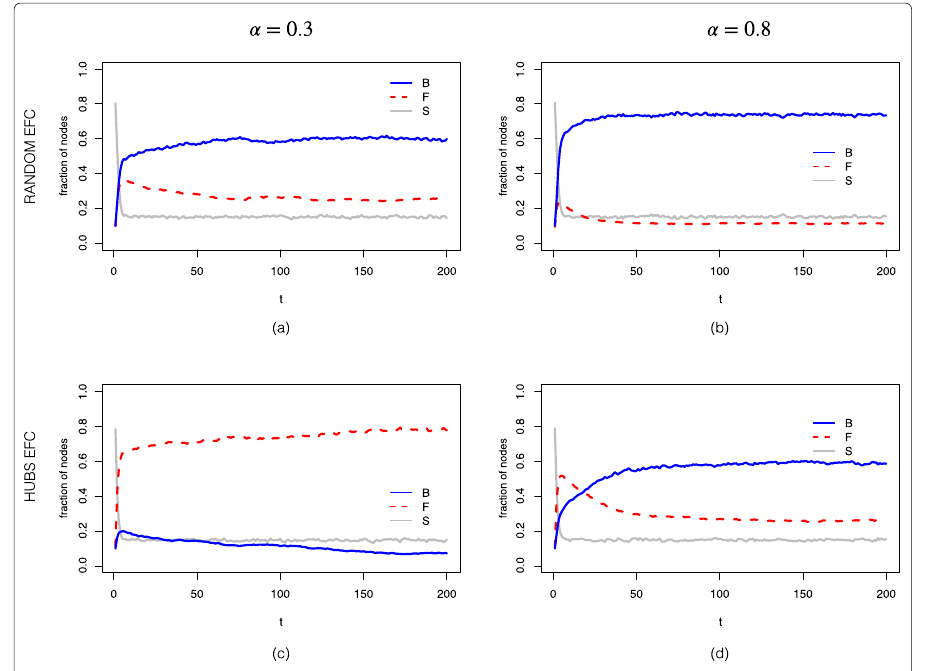
Fig. 4 Scale Free Network, debunking strategies: different strategies of choosing some nodes as eternal Fact Checkers with different values of credibility: ( a ) at random with α = 0.3, ( b ) at random with α = 0.8, ( c ) among the highest degree nodes with α = 0.3 ( d ) among the highest degree nodes with α = 0.8. Each plot refers to the averaged value of densities over 20 simulations on a Barabasi-Albert network of N = 1000 nodes, starting with B 0 = 100 seeders Believer and F 0 = 100 seeders Fact Checker. Please, observe that in the F 0 = 0.1, that is trivially impossible because F upper row it looks like that F ∞ is less than 0 are eternal N Fact-Checkers. This is due to a trivial over-plotting